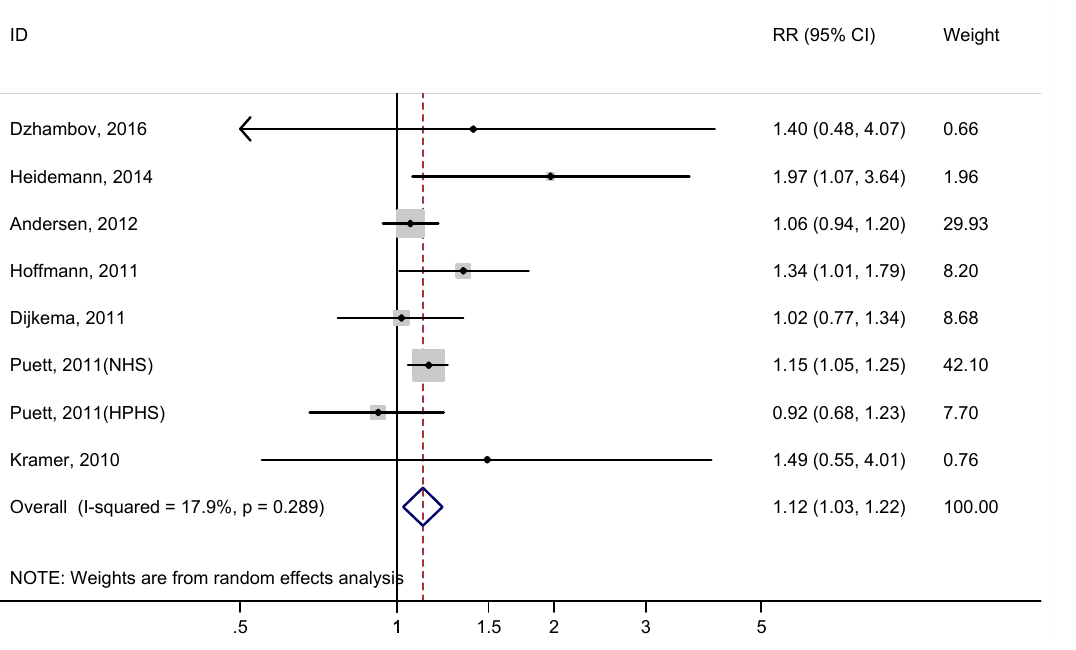
Figure 3. Adjusted relative risk (RR) of type 2 diabetes associated with residential proximity to major roadways.